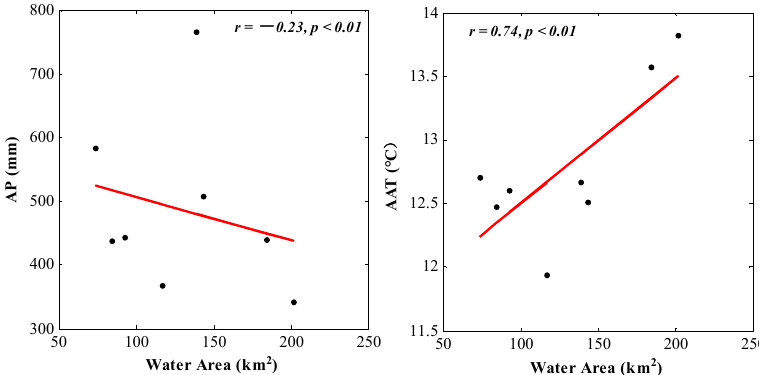
Figure 17. The Pearson correlation coefficient between water area and AAT and AP from 2008–2018.